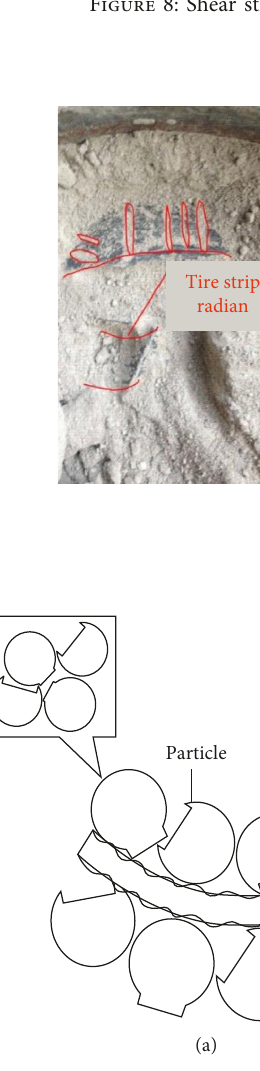
Figure 10: Changes of tire strips reinforced brick powder subjected to external